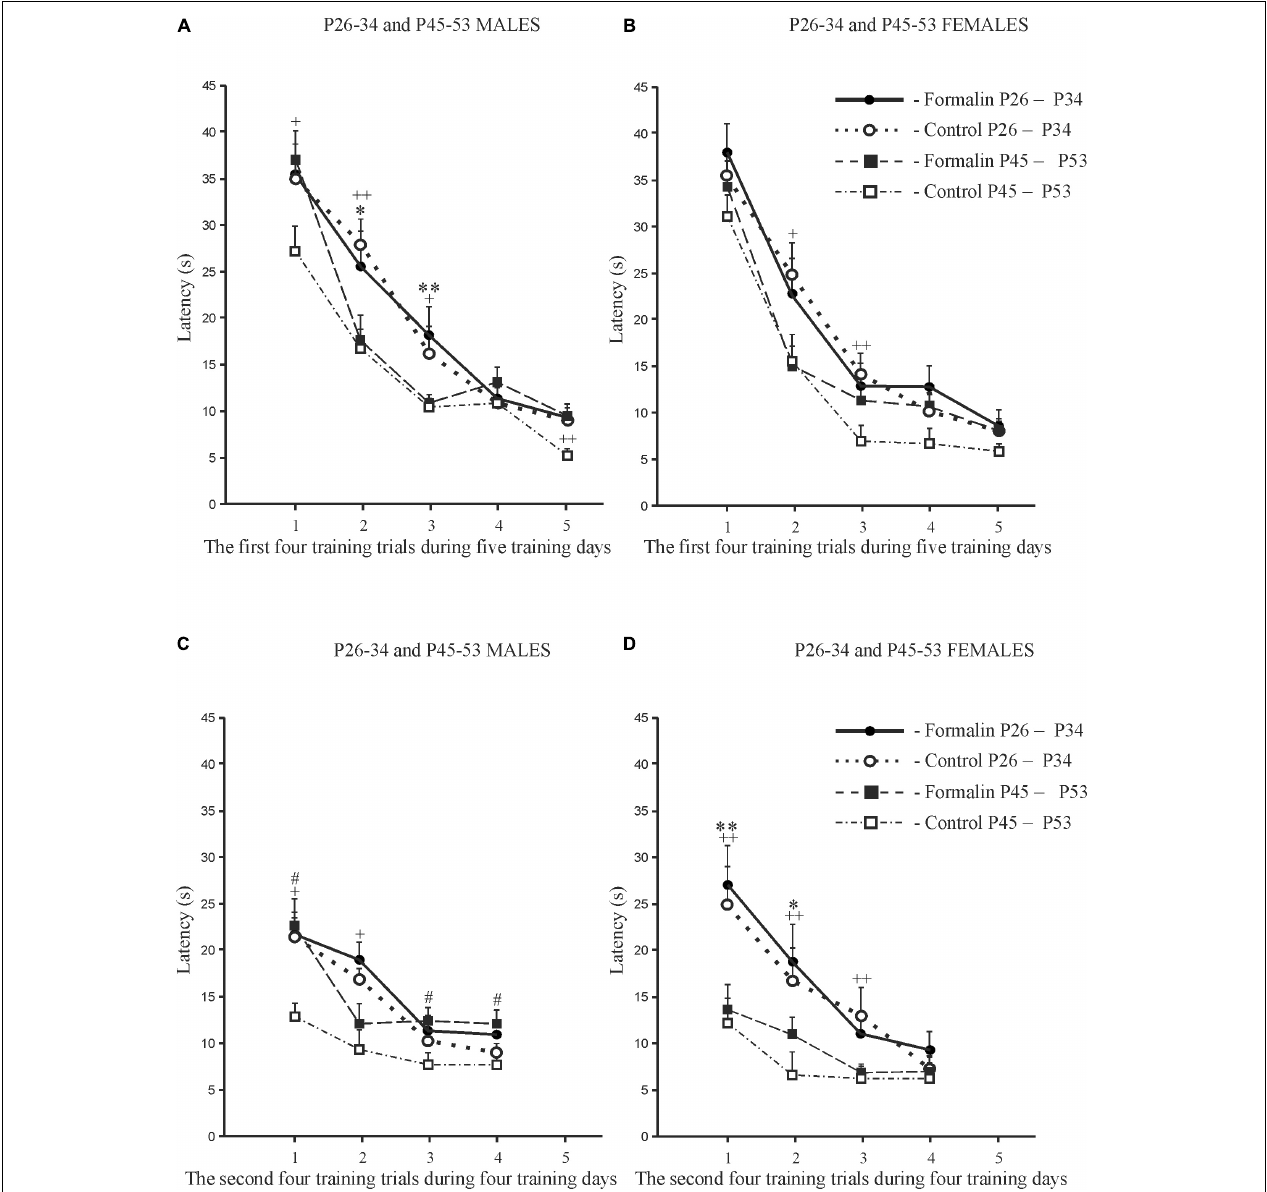
FIGURE 2 | Age and Sex effects in the mean ( ± SEM) latency to find the platform in Control and Formalin male and female rats in the first four training trials during five training days [early P26-34 and late P45-53 age groups (A,B) ] and in the second four training trials during four training days [early P26-34 and late P45-53 age groups (C,D) ]. ∗ p < 0.05, ∗∗ p < 0.01 age differences in Formalin rats, + p < 0.05, ++ p < 0.01 age differences in Control rats. # p < 0.05 sex differences in P45-P48 Formalin rats. Abscissa, training days. The number of the rats in the groups corresponds to the number of rats in Figure 1